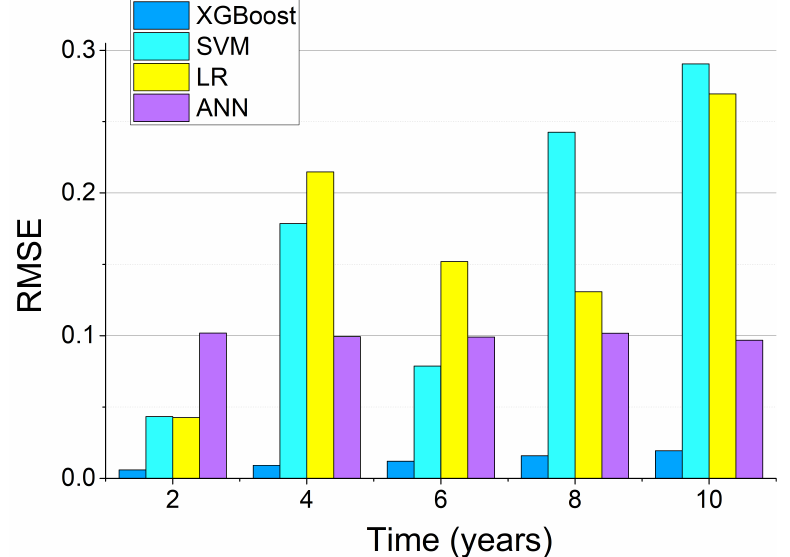
Figure 8. RMSEs of the different ML